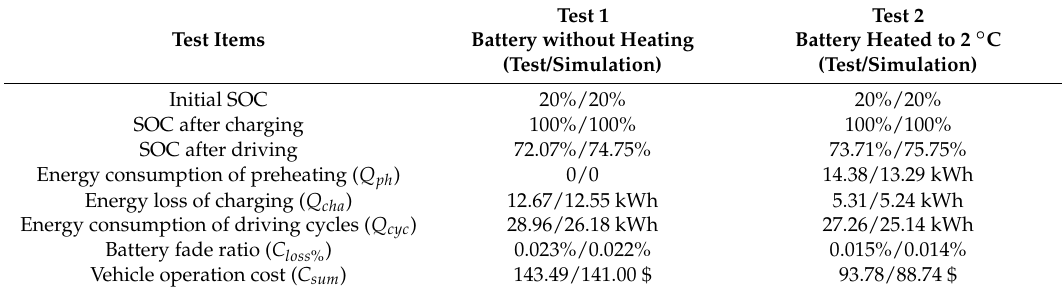
Table 3. Vehicle test results.